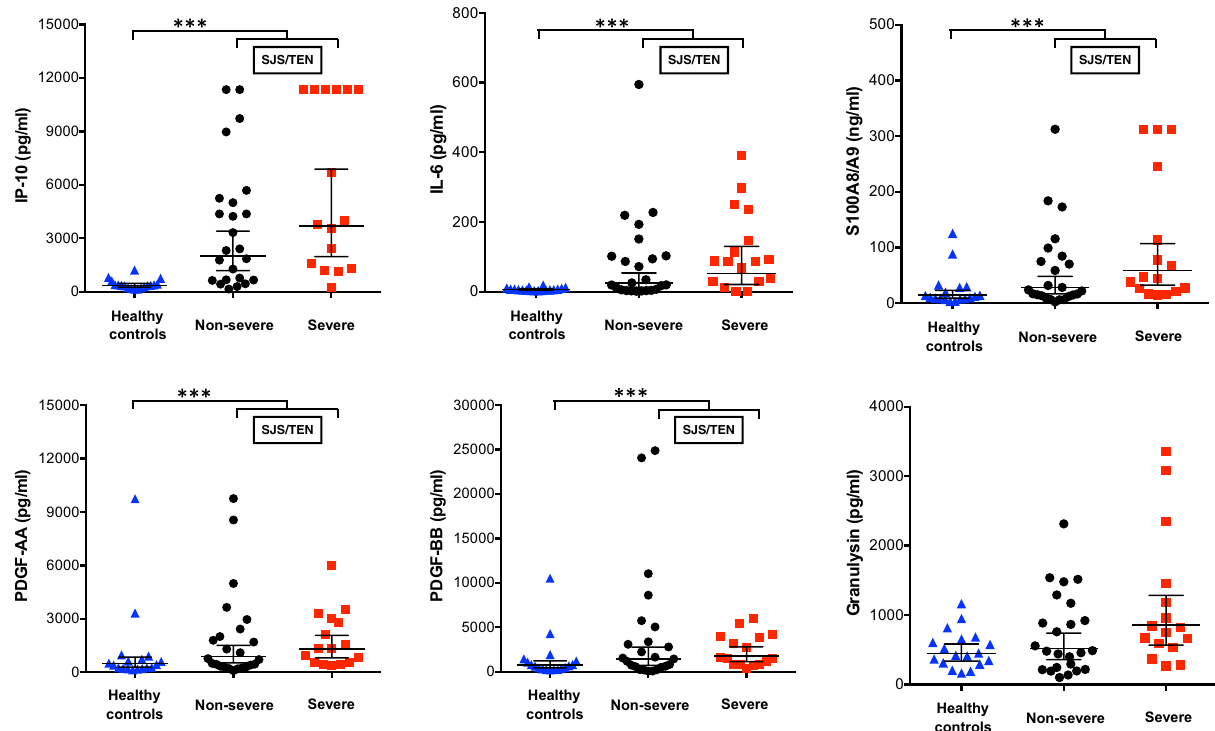
Figure 1. Scatter plot graphs of serum biomarker levels (geometric means) in healthy controls, and those from patients with SJS/TEN with non-severe and severe ocular complications. Representative scatter plot graphs of IP-10, IL-6, S100A8/A9, PDG-AA, PDG-BB, and granulysin levels. The geometric means with the 95% confidence interval of each biomarker in healthy controls (HC), SJS/TEN with non-severe ocular complications, and SJS/TEN with severe ocular complications group are shown. The Mann–Whitney test was used to compare biomarker levels between the HC and SJS/TEN groups and between the non-severe and severe ocular complications groups. IP-10, IL-6, S100A8/A9, PDG-AA, and PDG-BB were significantly higher in SJS/TEN group than in HC. When comparing the non-severe and severe ocular complication groups, any